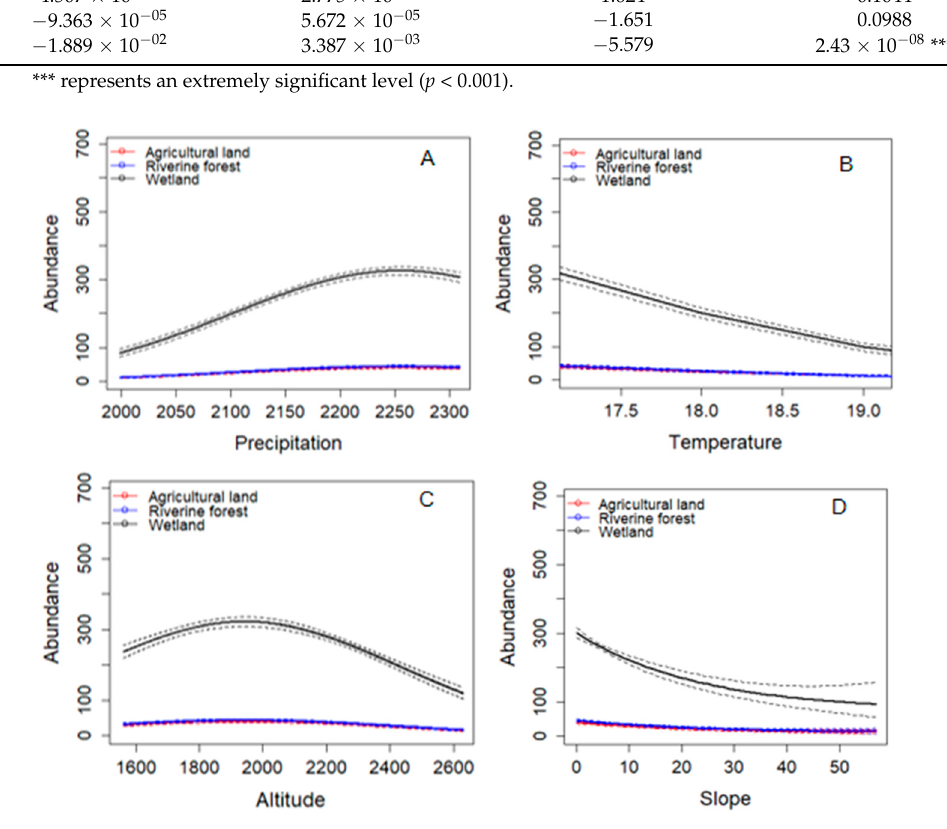
Figure 10. Effects of ( A ) precipitation, ( B ) temperature, ( C ) altitude, and ( D ) slope on the pattern of anuran abundance across habitat types. The solid lines represent trends, while the dashed lines represent the respective 95% credible intervals calculated using a Poisson